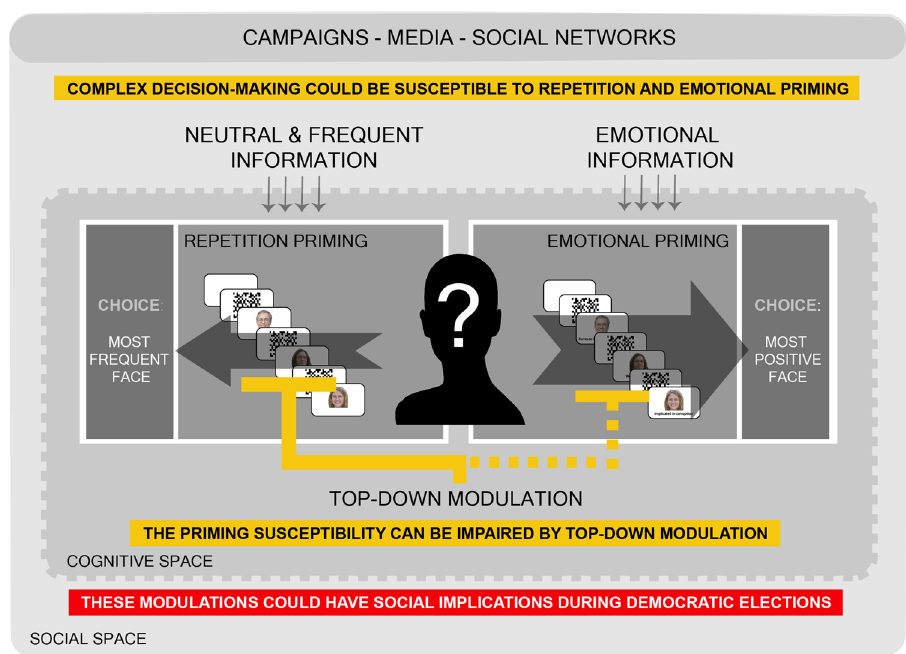
Figure 6. Integrative scheme of priming susceptibility and top-down modulation on Complex Decision- Making processes, at the cognitive and social level. Complex decision-making processes may be susceptible to repetitive and emotional priming, inducible by repetitive exposure to neutral or emotionally charged information (through campaigns, social networks or media). This susceptibility may be affected by top-down modulation. These processes may have social implications at the level of electoral